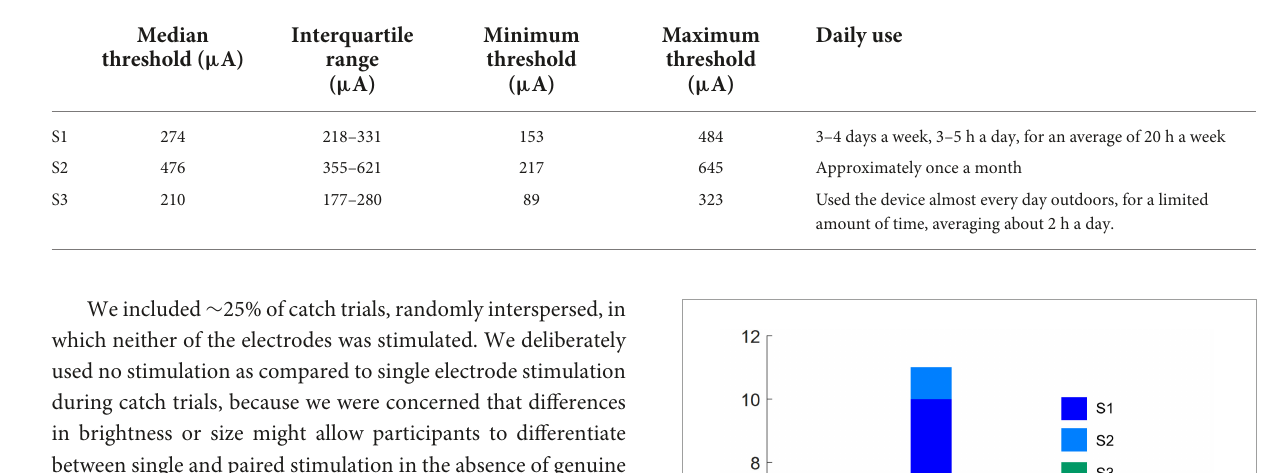
TABLE 3 Current amplitude detection thresholds (50% detection performance) and reports of daily usage.